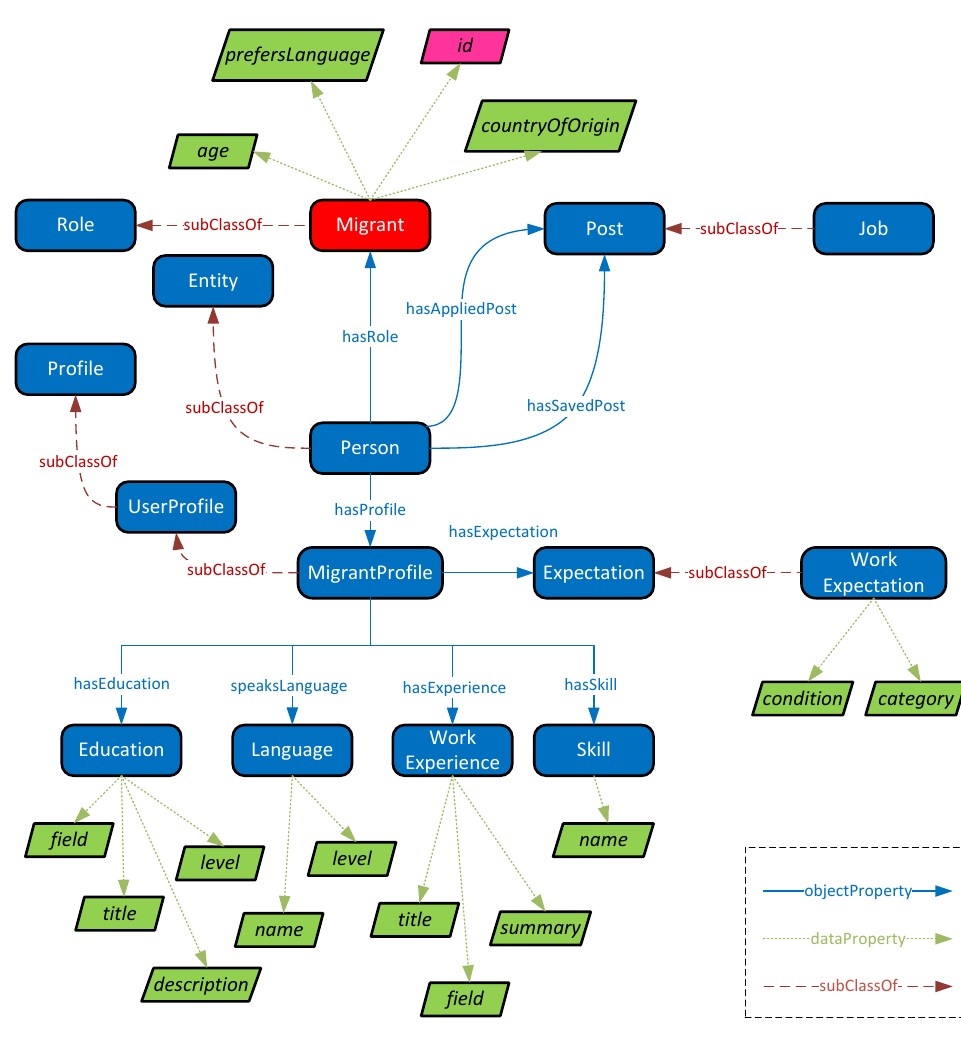
Figure 3. Migrant user